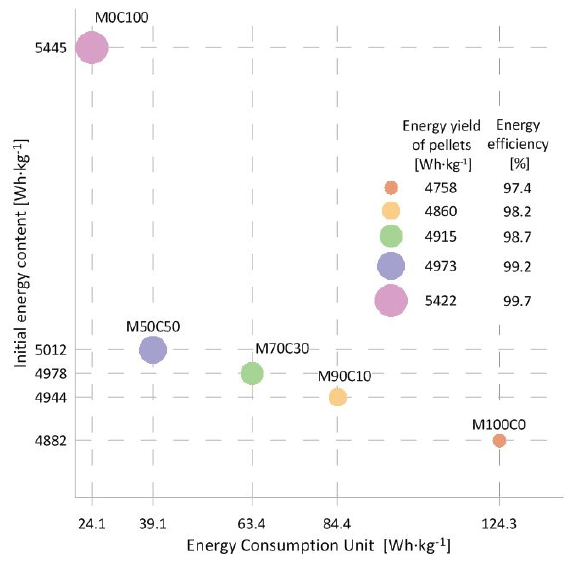
Figure 3. Energy yield and energy efficiency of pellets (EY and EE) vs. the relationships between initial energy content and unit energy consumption (IE and UEC). Individual bubbles are assigned both the EE and EY values as shown in the